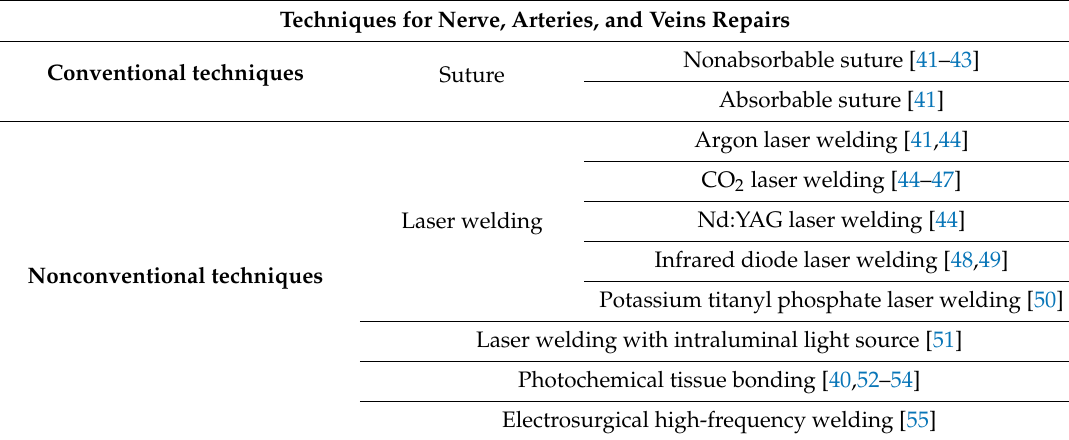
Table 1. Techniques for nerve, arteries, and veins